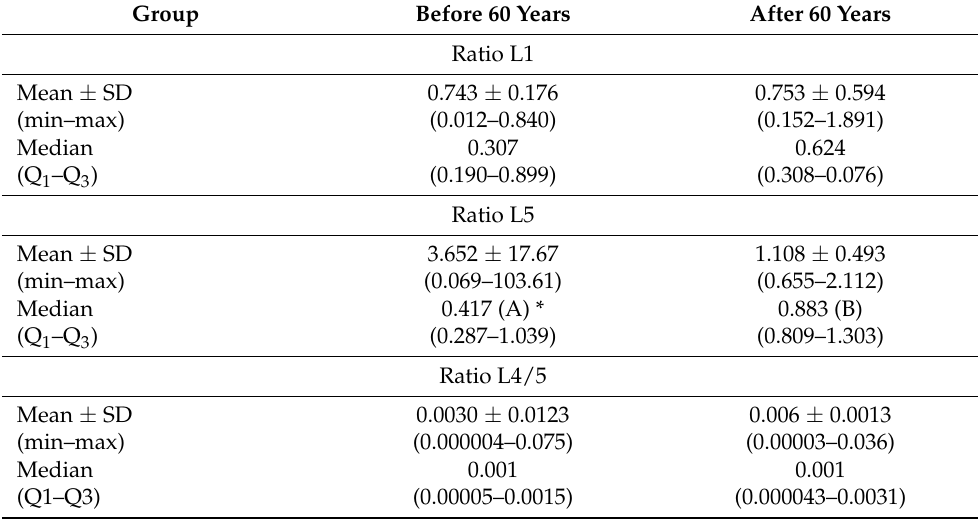
Table 6. Fat/water ratio of selected structures of the spine in 1 H-MRS in people with osteoarthritis of the spine before and after 60 years of